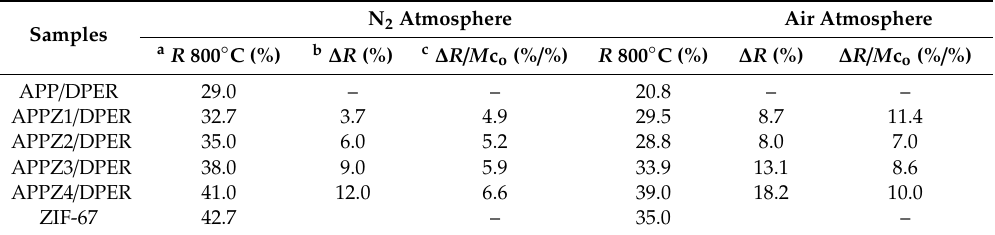
Table 2. Thermal stability of APP-ZIFs / DPER at 800 ◦